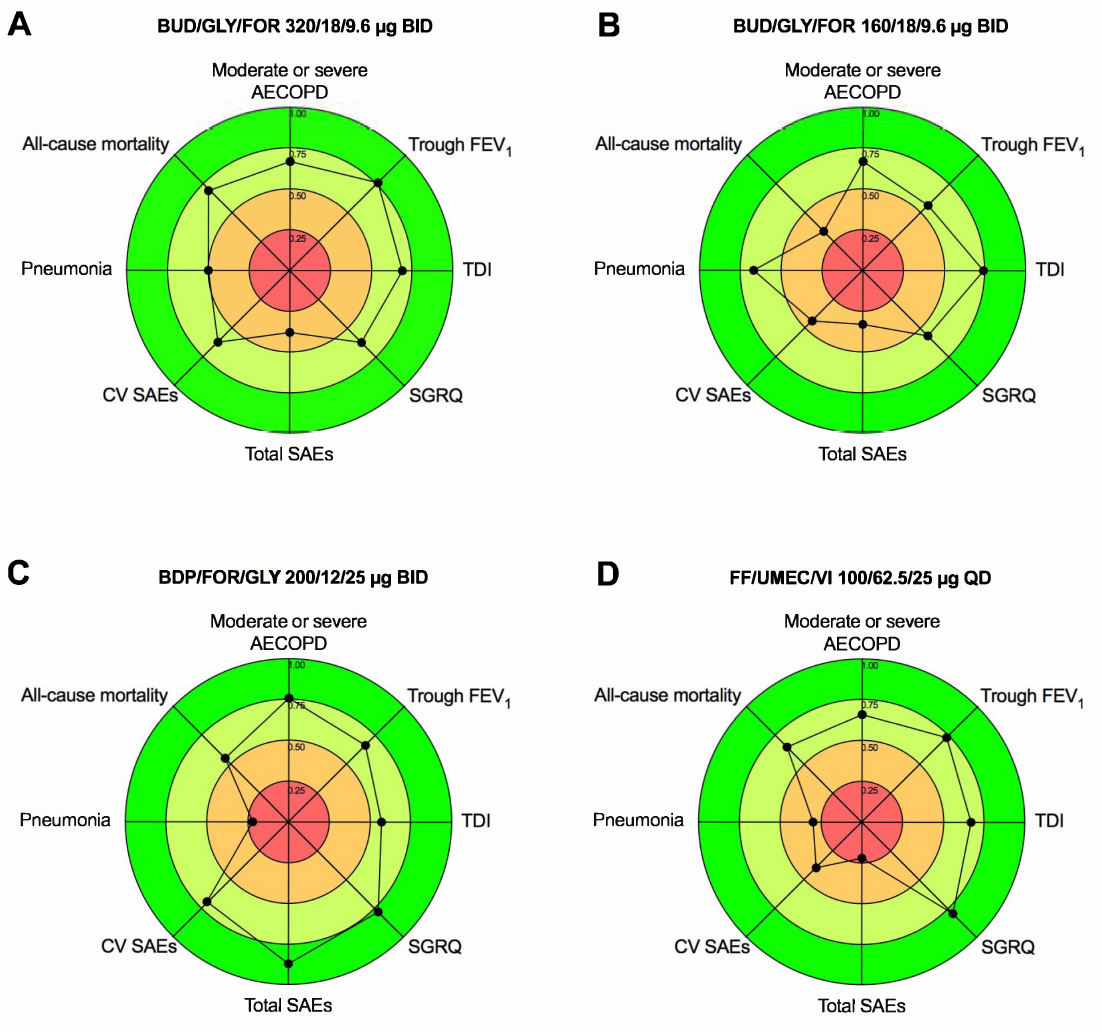
Figure 5. Graphical representation of combined efficacy/safety profile of BUD/GLY/FOR 320/18/9.6 µg BID ( A ), BUD/GLY/FOR 160/18/9.6 µg BID ( B ), BDP/FOR/GLY 200/12/25 µg BID ( C ), and FF/UMEC/VI 100/62.5/25 µg QD ( D ) in COPD patients according to the IBiS score; a greater area indicates a better efficacy/safety profile. AECOPD: acute exacerbation of COPD; BDP: beclomethasone dipropionate; BID: bis in die, twice daily; BUD: budesonide; COPD chronic obstructive pulmonary disease; CV: cardiovascular; FDC: fixed-dose combination; FEV 1 : forced expiratory volume in the first second; FF: fluticasone furoate; FOR: formoterol fumarate; GLY: glycopyrronium bromide or glycopyrrolate; ICS: inhaled corticosteroid; IBiS: Implemented Bidimensional SUCRA; LABA: long-acting β 2 -adrenoceptor agonist; LAMA: long-acting muscarinic antagonist; QD: quaque die, once daily; SAEs: serious adverse events; SGRQ: St. George’s Respiratory Questionnaire; SUCRA: surface under the cumulative ranking curve; TDI: transitional dyspnea index; UMEC: umeclidinium bromide; VI: